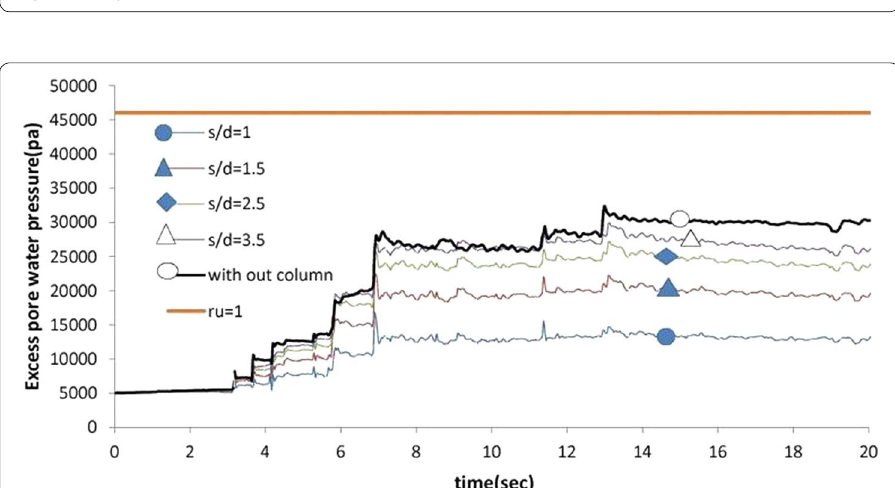
Fig. 10 Changes of excess pore water pressure at depth of 5